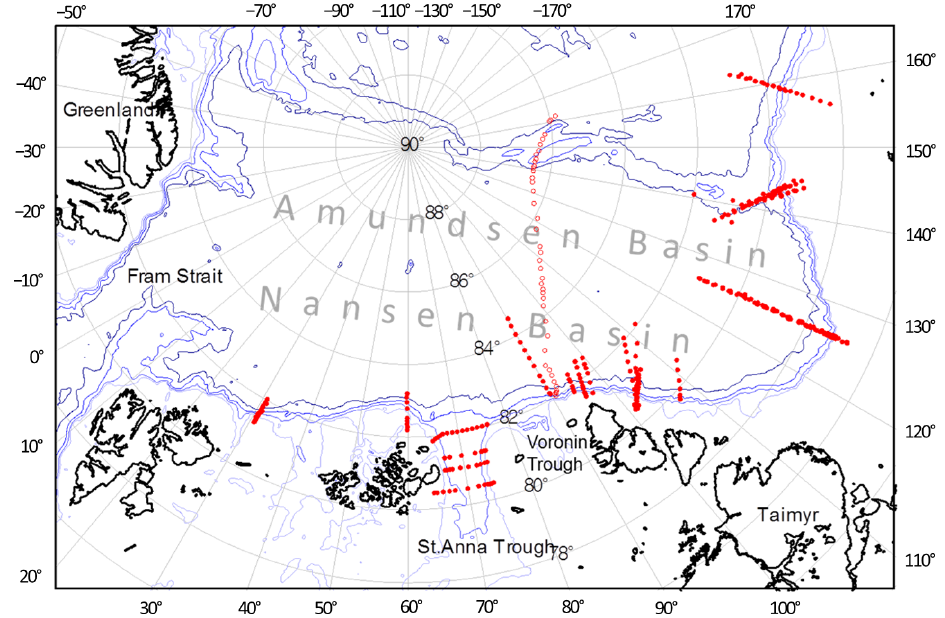
Figure 1. Bathymetric map of the Eurasian Basin with 300, 500, 1000, and 2000m contours shown. The red filled and blank circles are the locations of CTD stations on the NABOS and PS96 transects, respectively.